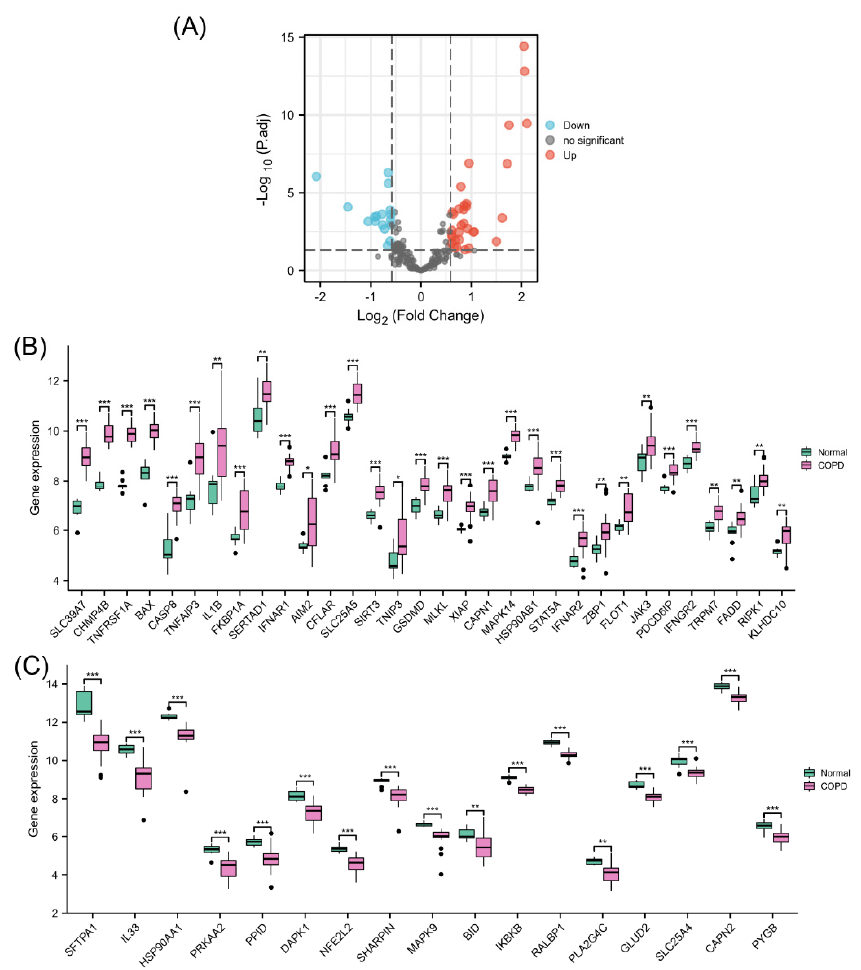
Figure 2. Identification of differentially expressed NRGs. ( A ) Volcano plot of NRGs showing differential expression between the COPD and normal groups. ( B ) Box plot of 32 upregulated differentially expressed NRGs. ( C ) Box plot of 17 downregulated differentially expressed NRGs. * p < 0.05, ** p < 0.01, *** p < 0.001.